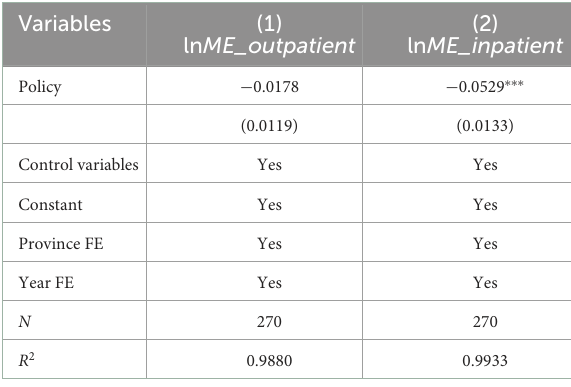
TABLE 4 PSM-DID estimation. TABLE 5 Entropy balancing